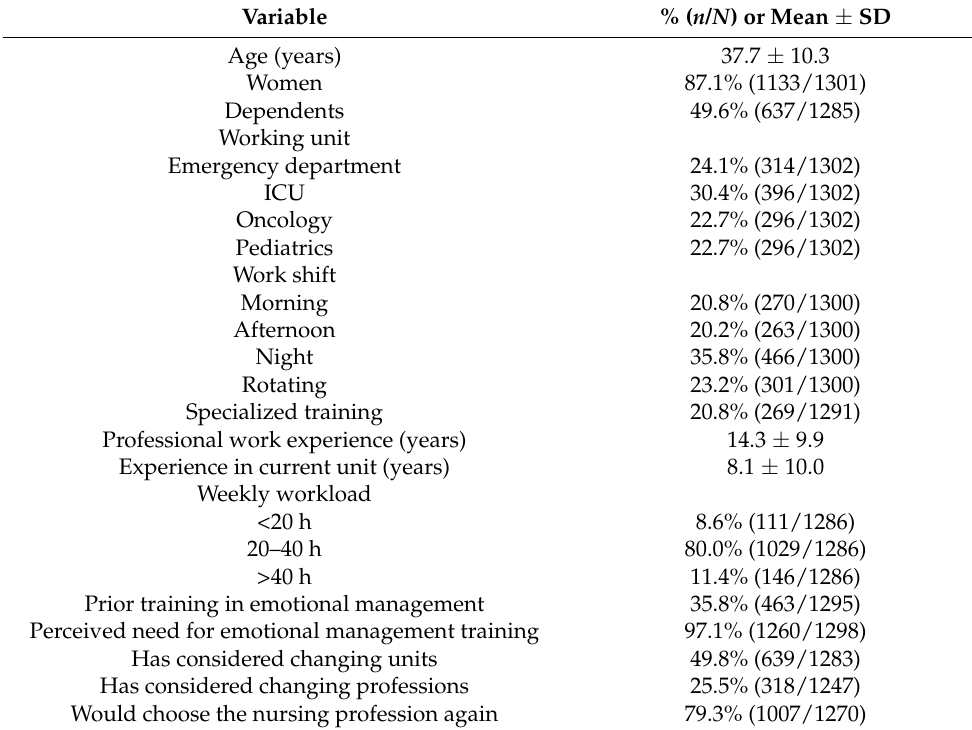
Table 1. Description of professional